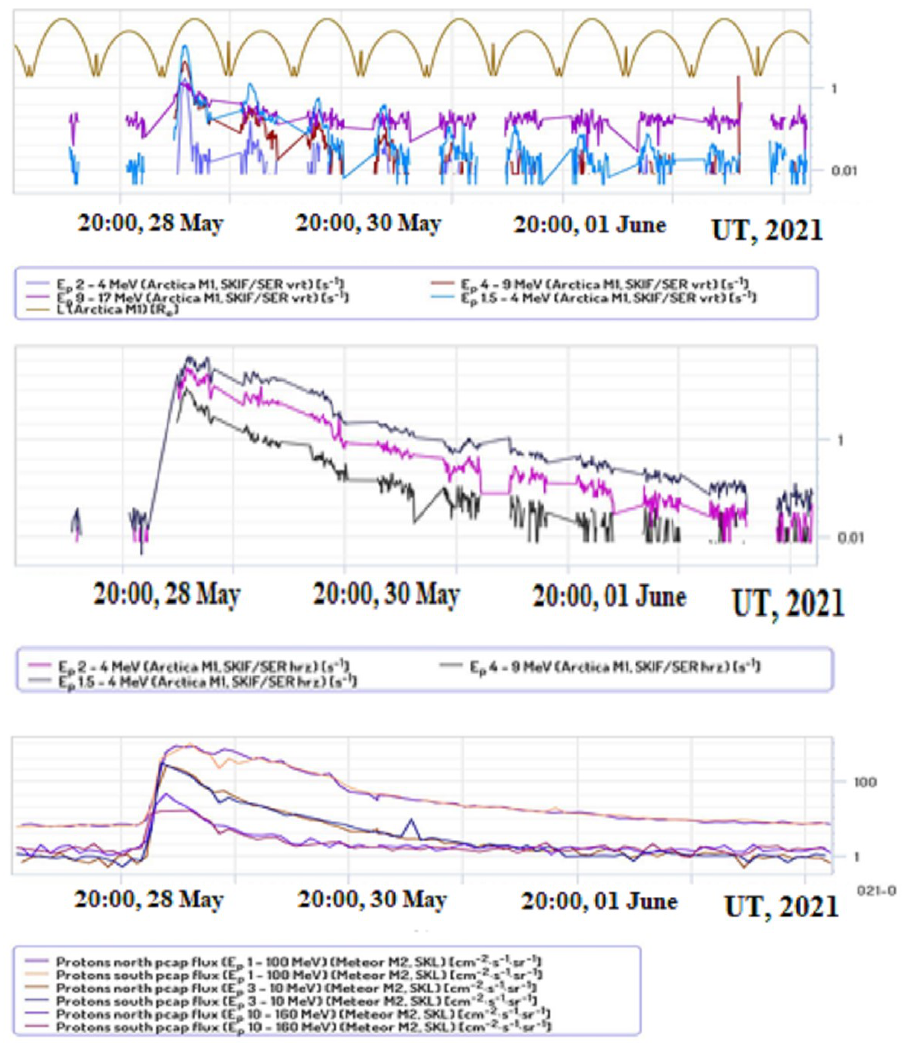
Fig. 8. Time profiles of solar proton fluxes during 28.05 - 02.06